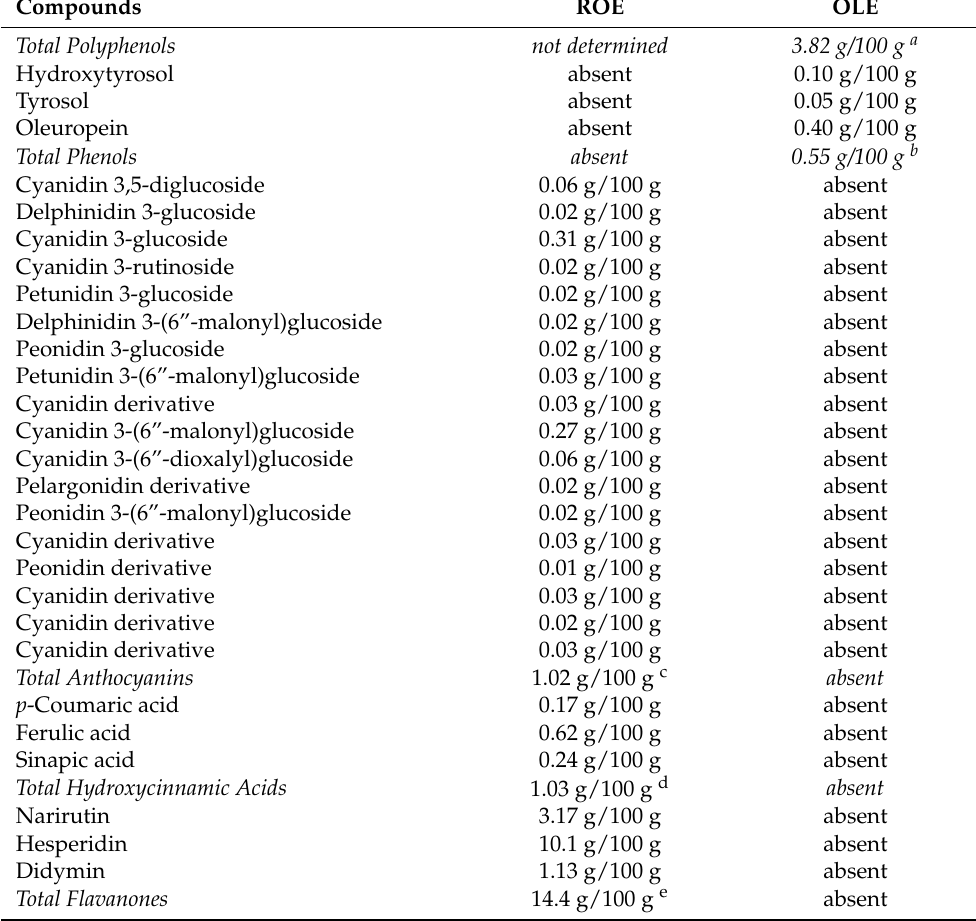
Table 1. Chemical composition of ROE and OLE used in this study. Results are expressed as: a g of gallic acid equivalents (GAE)/100 g of OLE; b g of oleuropein equivalents/100 g of OLE; c g of cyanidin 3-glucoside equivalents/100g of ROE; d g of ferulic acid equivalents/100 g of ROE; e g of hesperidin equivalents/100 g of